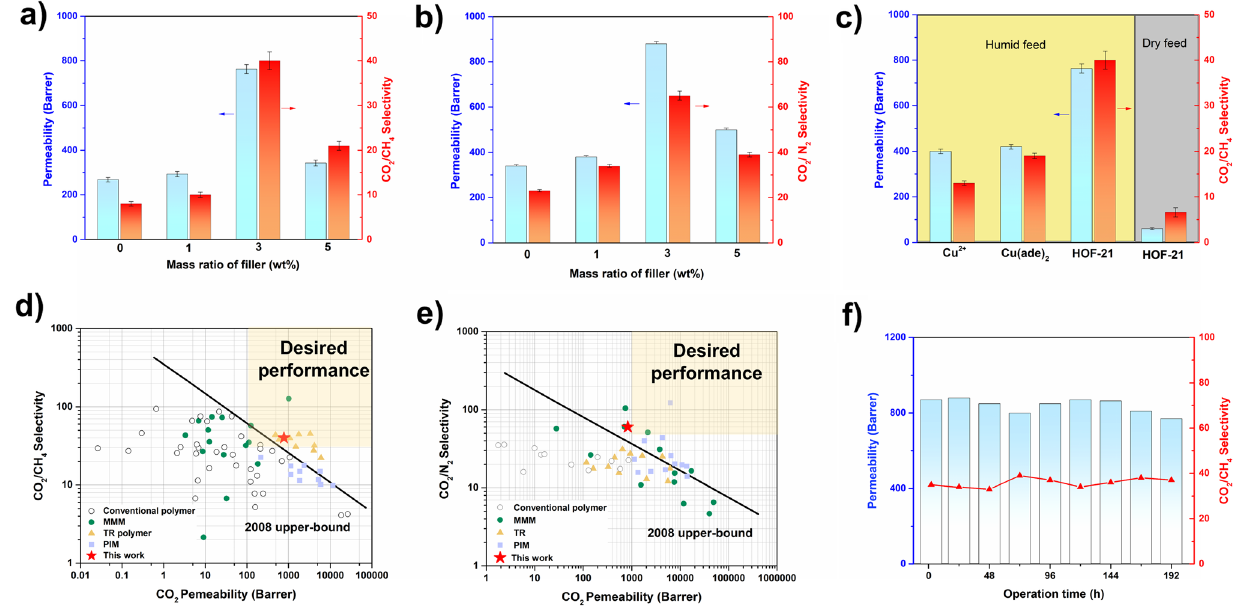
Fig. 4 Separation performance of a CO 2 /CH 4 and b CO 2 /N 2 mixed gas separation performance of MMMs with different filler loadings. c Sepa- ration performance of MMMs with different fillers. The comparison of different membranes with best performance separation of the d CO 2 /CH 4 and e CO 2 /N 2. The data points extracted from reported literature [28–30]. f Long-term operation stability for CO 2 /CH